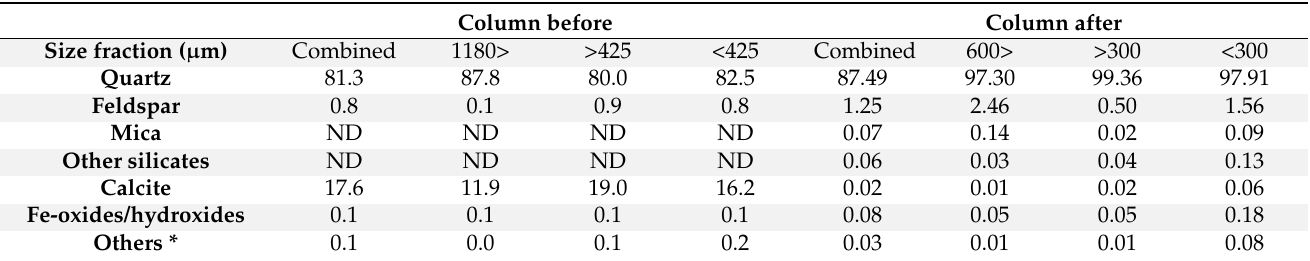
Table 4. Mineral composition of the raw sand determined using QEMSCAN ® . Column before Column